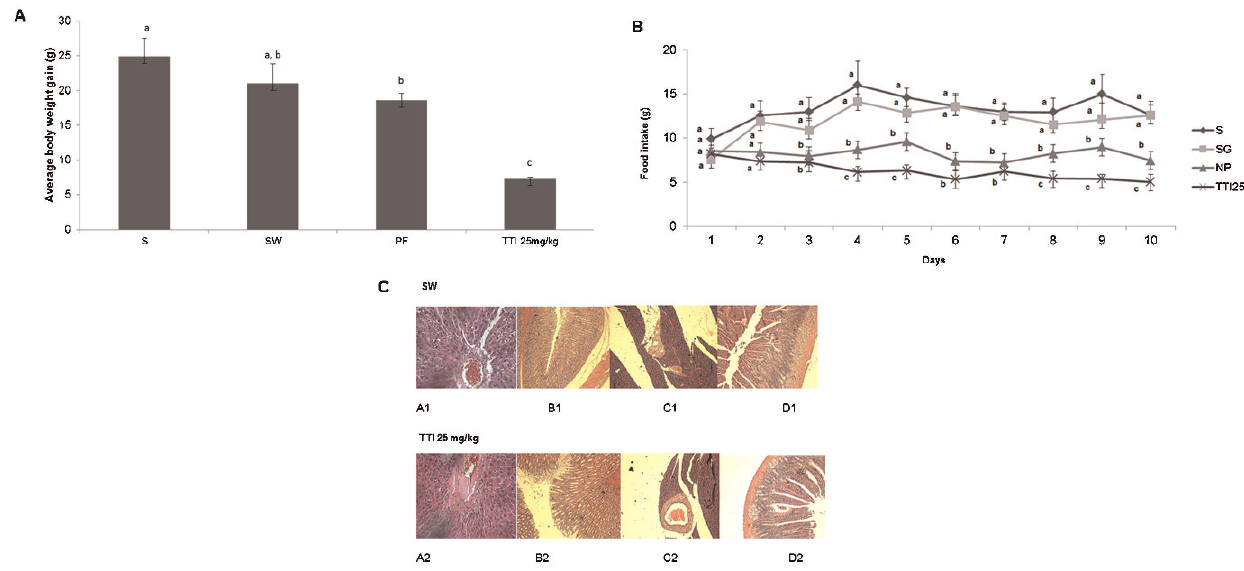
Figure 2 - Wistar rats were subjected to oral gavage with the standard diet AIN-93G (S, n=6), standard diet AIN-93G + 1 mL of water (SW, n=6), protein-free diet (PF, n=6), or AIN-93G + 25 mg/kg tamarind trypsin inhibitor in 1 mL water (25 mg/kg TTI, n=6) for 11 days. A) The evolution of body weight, in grams (g). The results are expressed as the mean ¡ standard deviation of each group. Different letters indicate p , 0.05 using one-way ANOVA and Tukey’s post-hoc test. B) The average food intake in grams per day (g/day). The results are expressed as the mean ¡ standard deviation of each group. C) Assessment of the histopathological alterations in the SW and TTI groups. A1 and A2: liver sections (40 6 magnification); B1 and B2: stomach sections (10 6 magnification); C1 and C2: pancreatic sections (10 6 magnifications); D1 and D2: bowel sections (10 The food consumption data corroborates weight gain data. Figure 2B shows that animals treated with 25 mg/kg TTI had the lowest food consumption compared with the other studied groups.